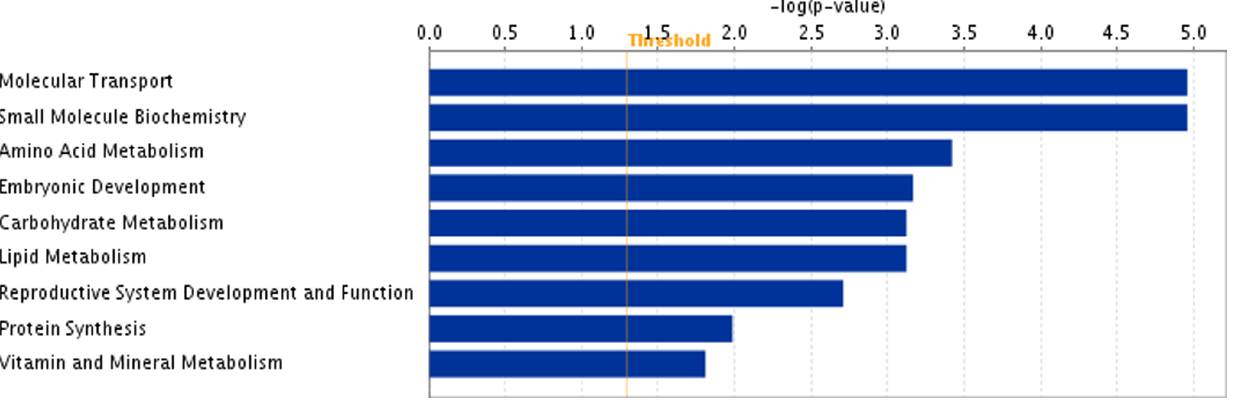
one at 48 Mb (SNP) on gene LOC100516362 and one at 118 Mb (SNP) on gene IRG6 (Table 7). Grindflek et al. [2] found two QTL regions on the same chromosome for androstenone at 38 to 40 Mb